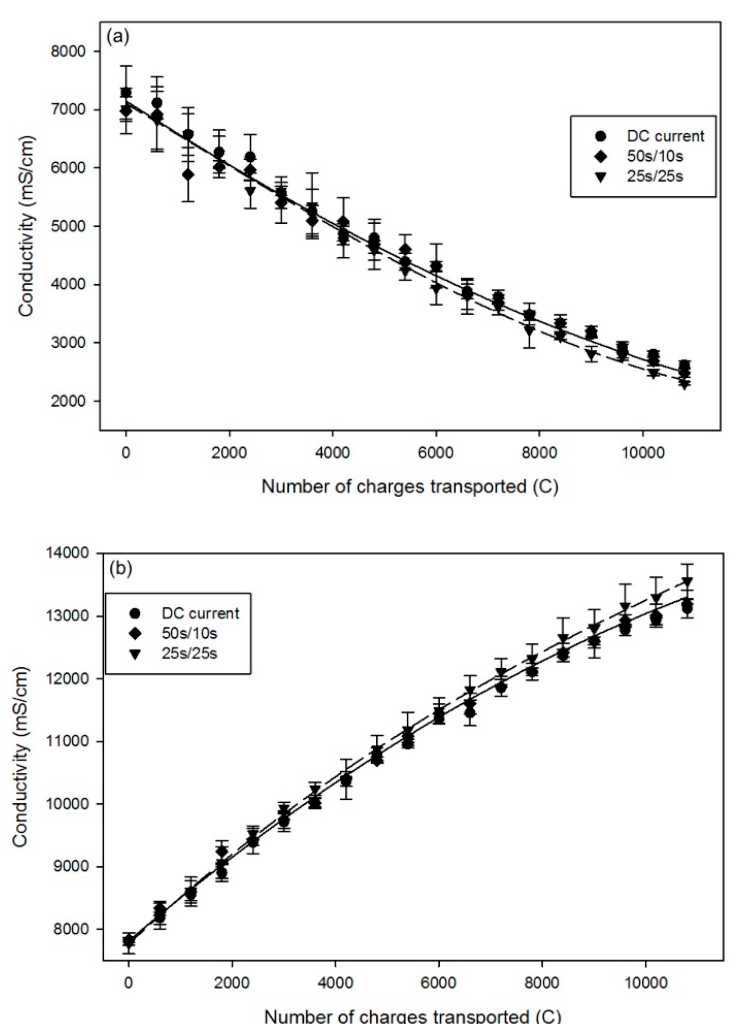
Figure 3. Conductivity evolution for DC (dots), PEF 50 s/10 s (rhombuses) and PEF 25 s/25 s (inverted triangles) current conditions in ( a ) AWComp and ( b ) OAComp.